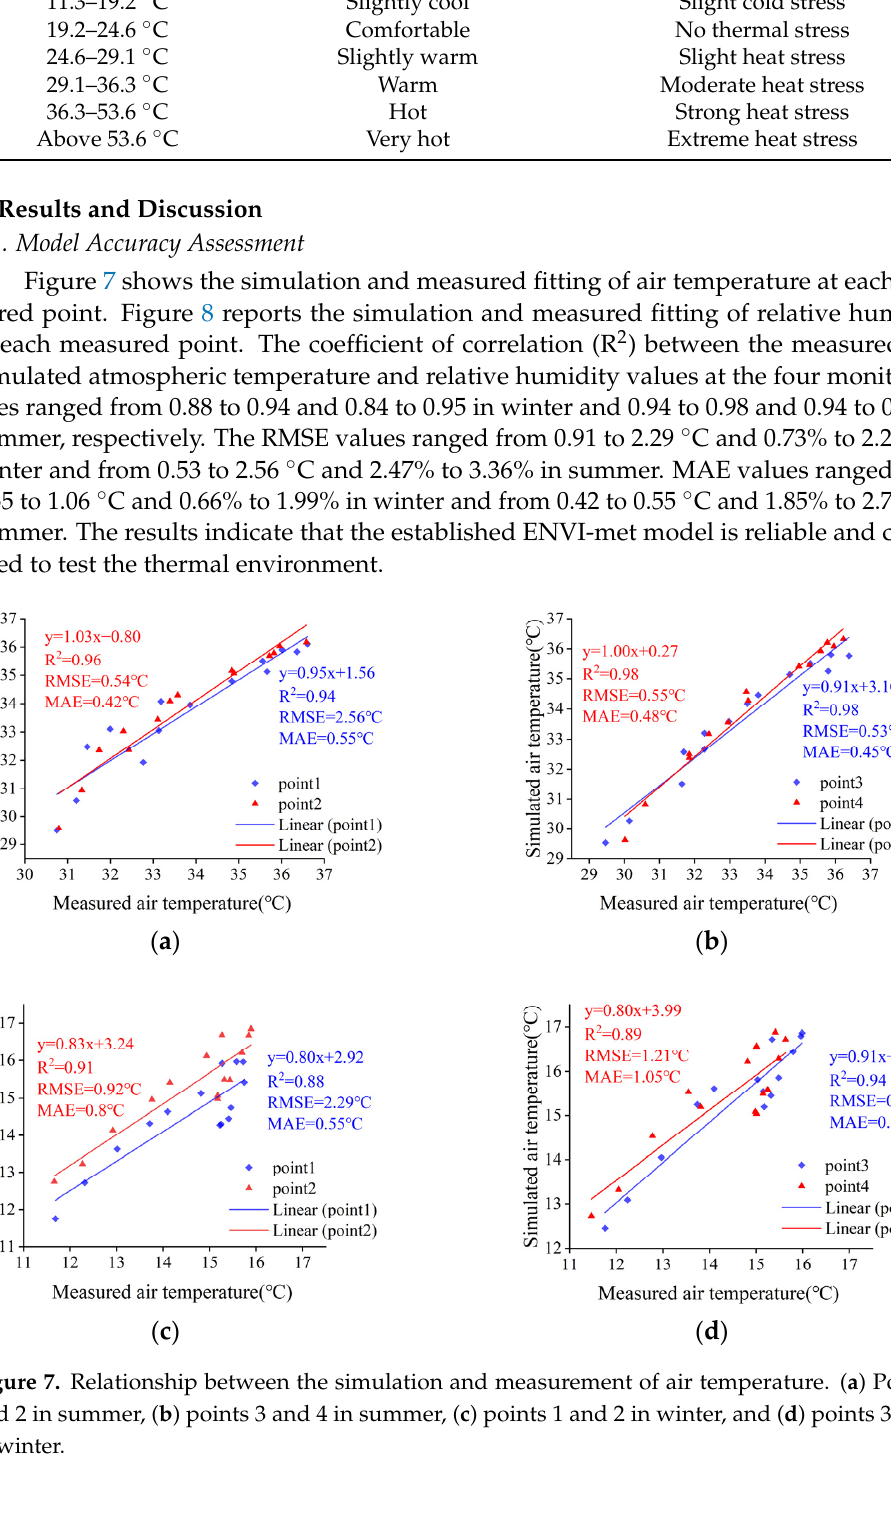
( d ) Figure 8. Relationship between the simulation and measurement for relative humidity. ( a ) Points 1 and 2 in summer, ( b ) points 3 and 4 in summer, ( c ) points 1 and 2 in winter, and ( d ) points 3 and 4 in winter.